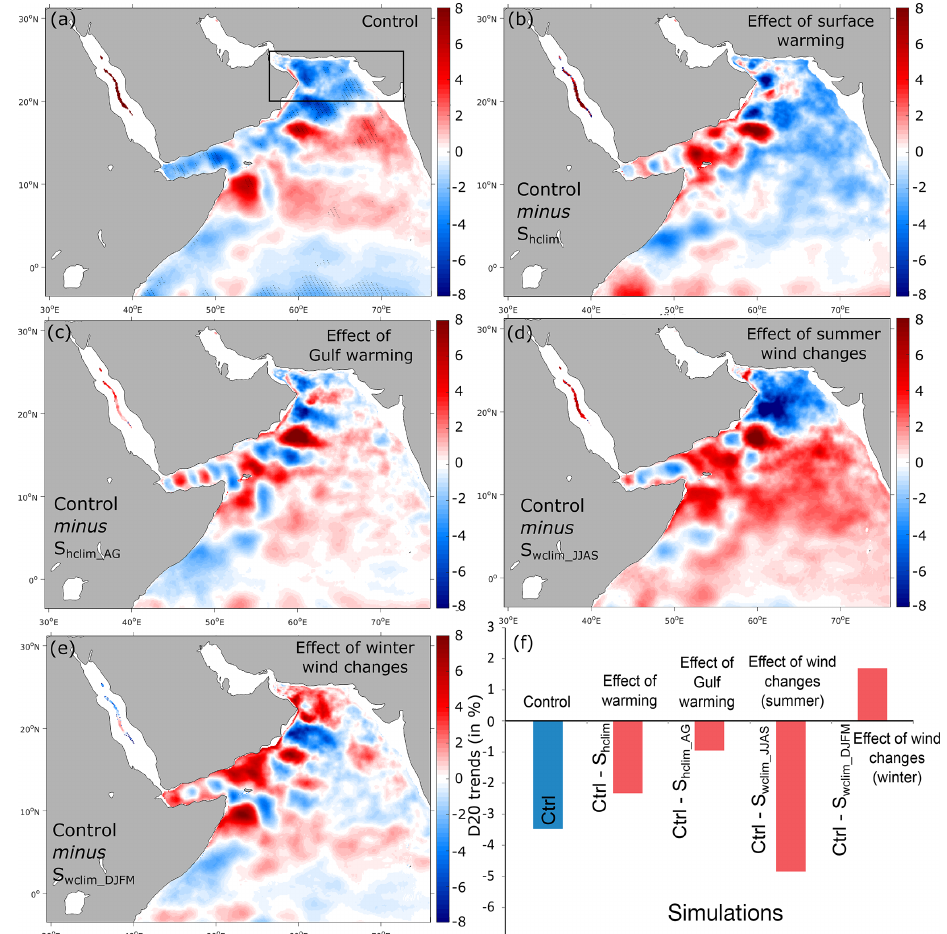
Figure 10. Effects of different atmospheric forcing perturbations on thermocline depth. (a) Linear trends in the depth of isotherm 20 ◦ C (D20) in the control run (in meters per decade). (b–e) Difference in D20 trends between the control run and the S hclim (i.e., effect of warming), S hclim_AG (i.e., effect of Gulf warming), S wclim_JJAS (i.e., effect of summer wind intensification) and S wclim_DJFM (i.e., effect of winter wind changes) sensitivity simulations (in meters per decade). (f) Difference in D20 trends in the northern AS box between the control and the different sensitivity simulations (in percent of the mean thermocline depth over the 1982–2010